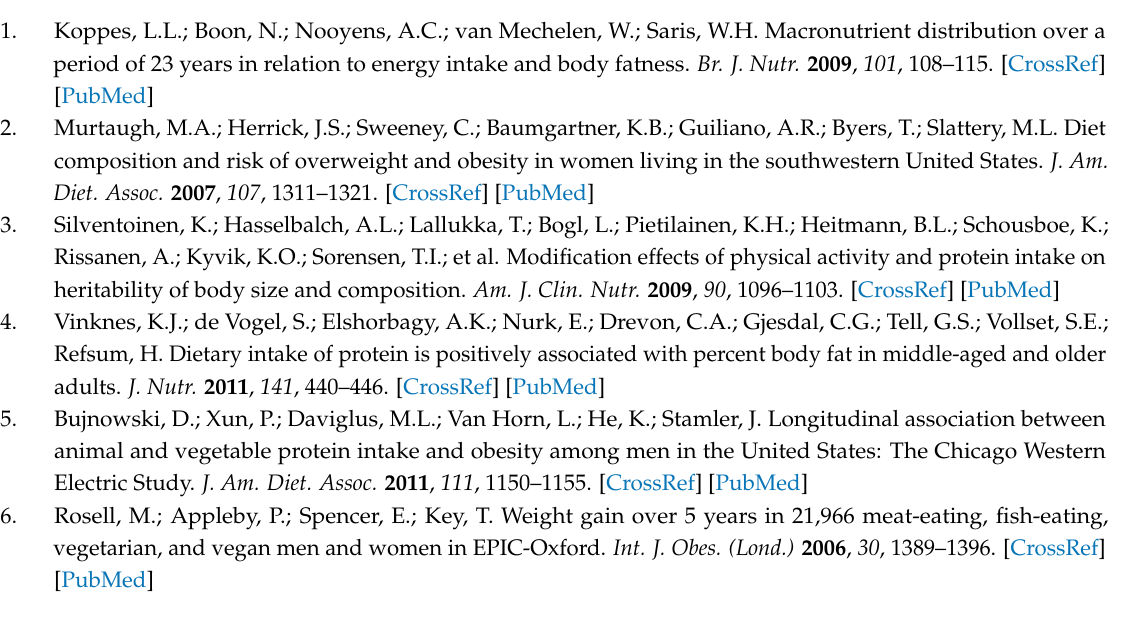
Table S1: A typical daily menu in the 7-day diet; Table S2: Average nutrient content and composition in the 7-day diet for each intervention group; Table S3: Change from baseline in metabolic parameters; Table S4: Fatty acids and SCD activity